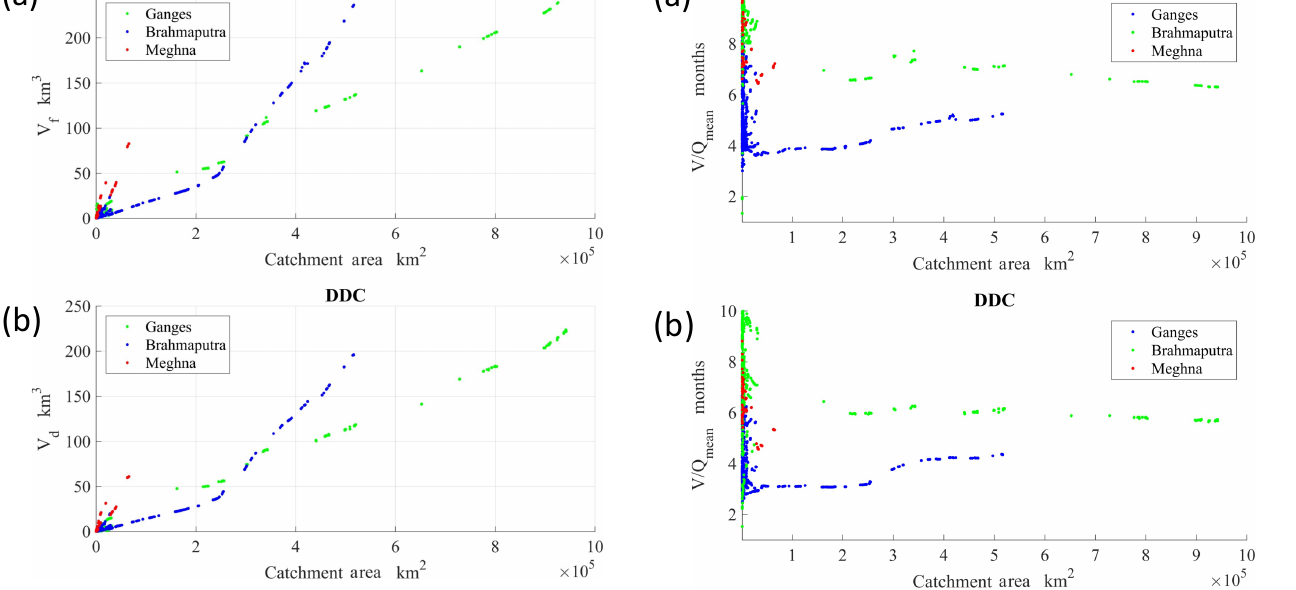
Figure 13. Relation between necessary storage in months and catchment area (km 2 ) at all grid points of the basin with maintaining discharge Q T = Q mean for (a) flood and (b) drought management with a 5-year return